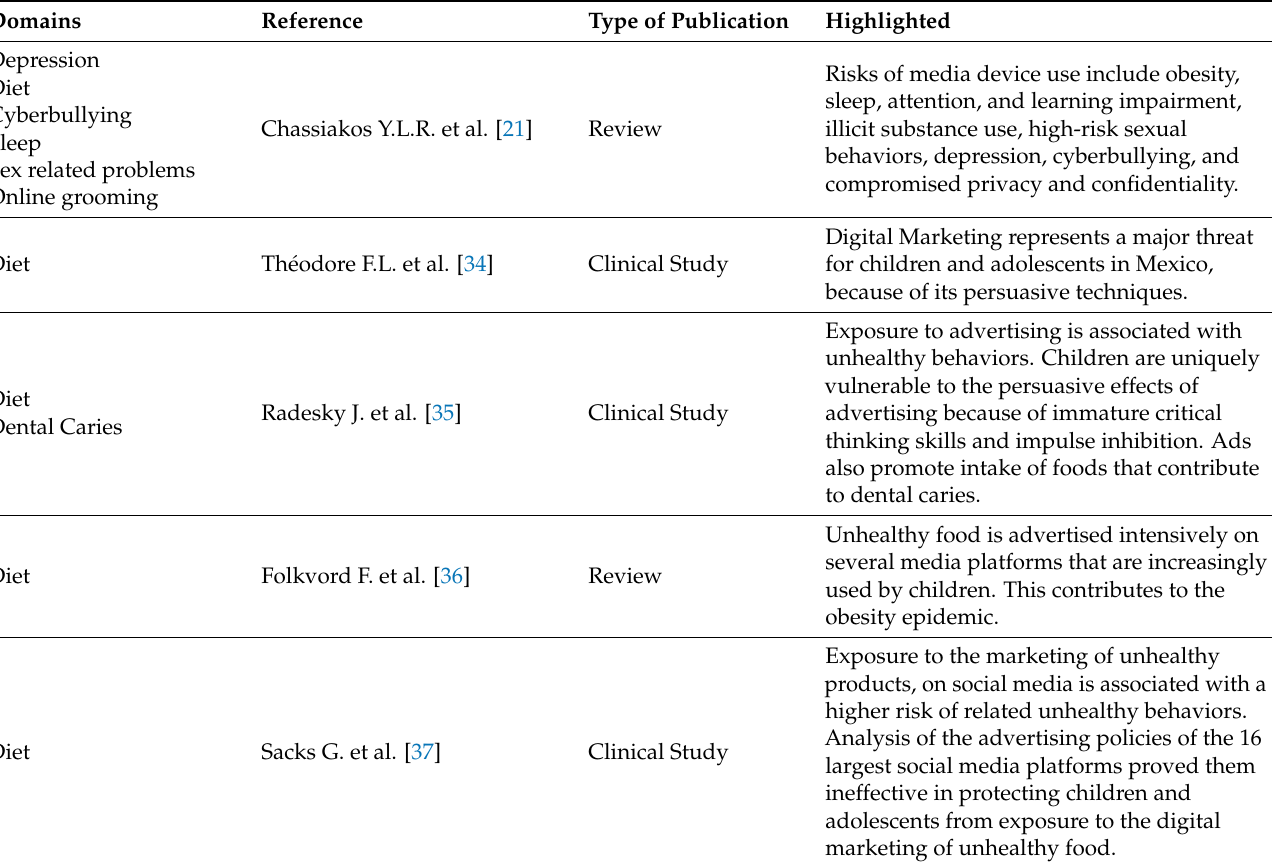
Table 3. Social media and